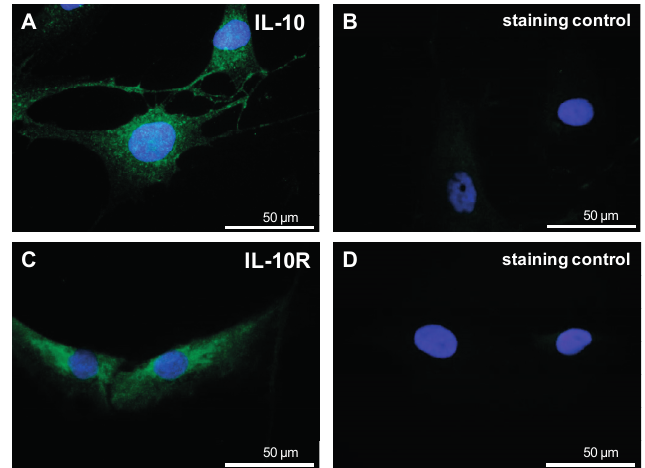
Figure 4. IL-10 and IL-10R α expression in undifferentiated MSCs. Undifferentiated MSCs were cultured for at least 3 passages in monolayer culture and immunolabelled with IL-10 ( A ) or IL-10R ( C ) specific antibodies or respective isotype controls ( B , D ) and Alexa-488 coupled secondary antibodies (green). Cell nuclei were counterstained using DAPI (blue). A representative experiment of 4 independent tests with cells of different donors is shown. Scale bars = 50